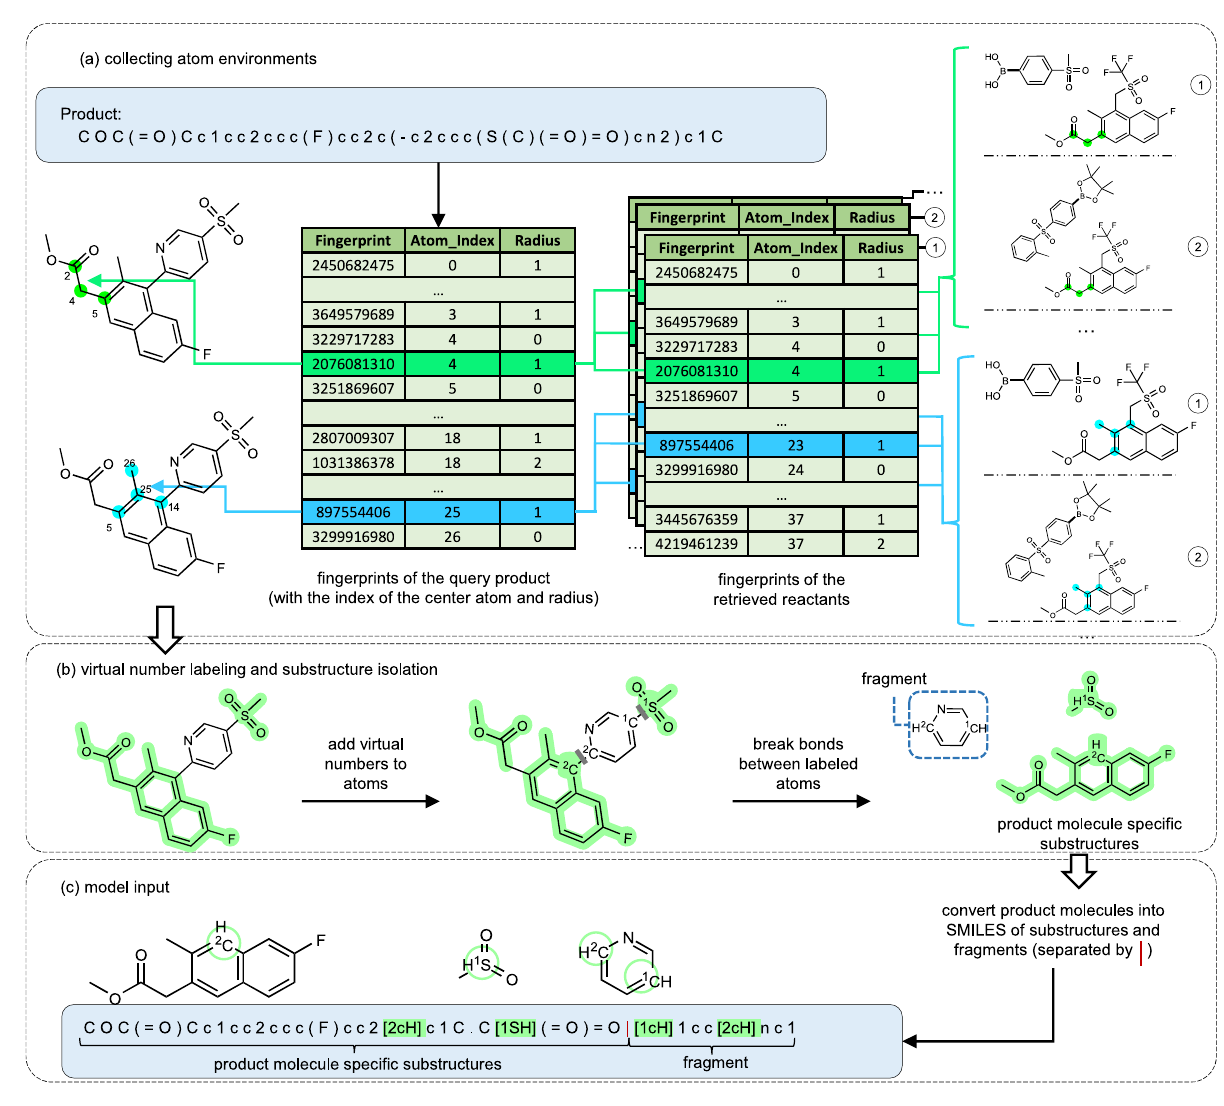
Fig. 7 | Substructure extraction. a Collecting atom environments, the atom environments of fi ngerprints 2076081310 and 897554406 in the product and the retrieved candidates are highlighted in green and blue, respectively. b Virtual number labeling and substructure isolation, the virtually labeled substructures are